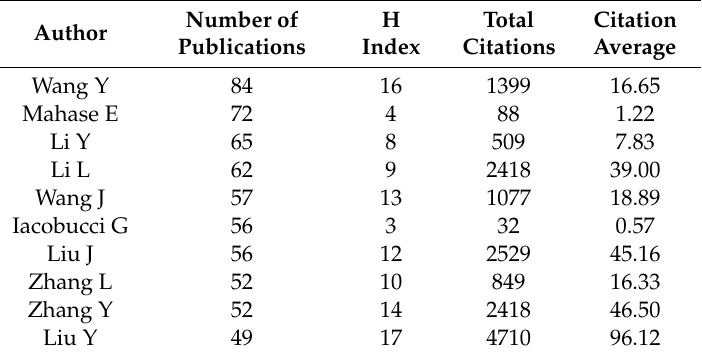
Table 3. Top 10 authors with the largest number of